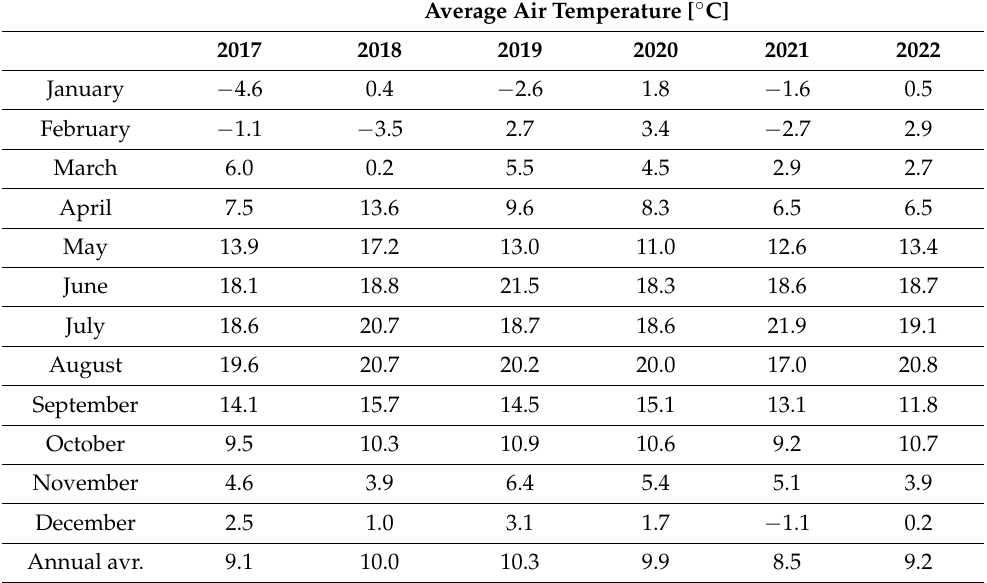
Table 1. Average monthly and annual temperatures in Osiny for the period